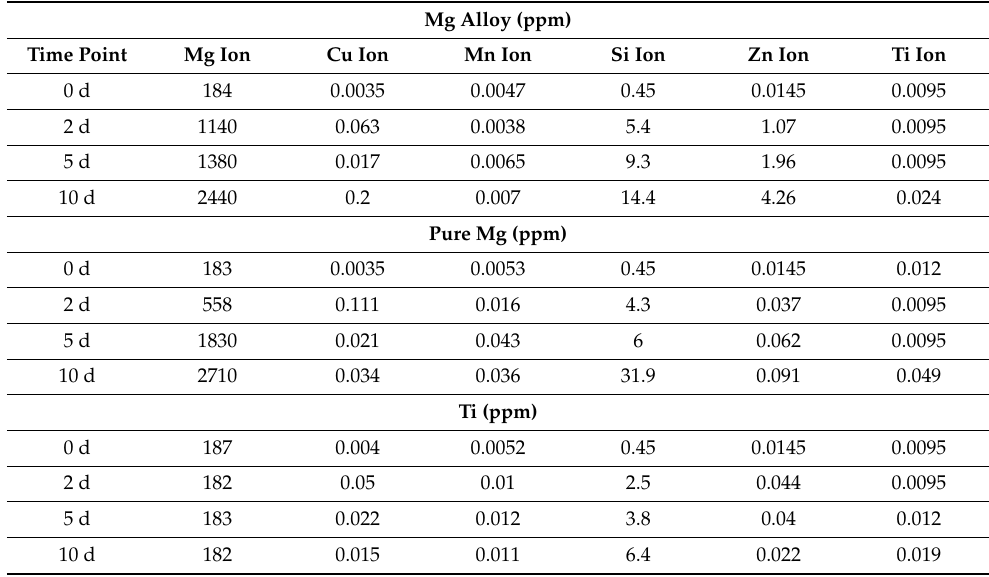
Table 2. The concentration of ions released was analysed by inductively coupled plasma mass spectrometry (ICP-MS) during the immersion process, showing the concentration of Mg, Cu, Mn, Si, Zn, and Ti ions in parts per million (ppm).